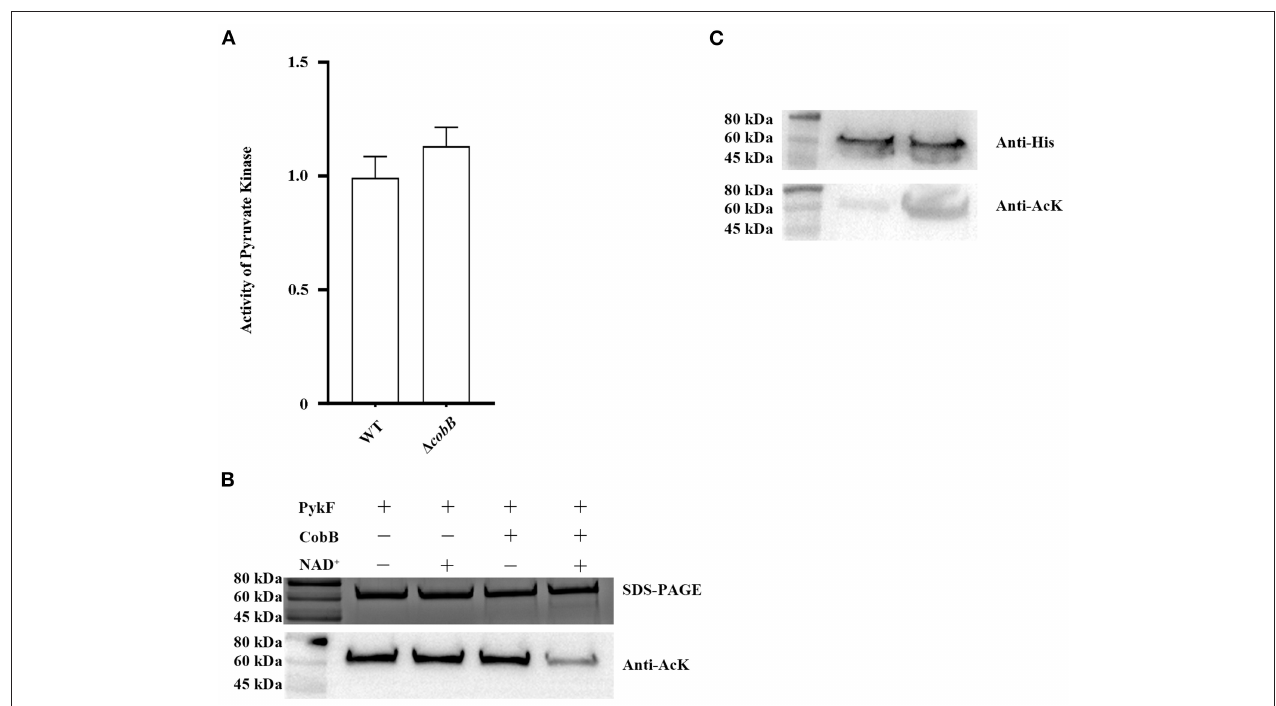
FIGURE 3 | (A) CobB deacetylation PykF in vitro . Top line, Western blot was performed on PykF treated with CobB for 1h. The same amount of protein was loaded in all lanes. Bottom line, pyruvate kinase activity was measured, and the enzyme activity of lane 1 sample was set as 1. Mean values and standard deviations were calculated based on three replicates ( n = 3). Two-tailed P -values were determined by the t -test, and the significance level is 0.05. (B) CobB deacetylates PykF in vivo . Top line, Western blot analysis of purified PykF from V. alginolyticus WT: pykF and 1 cobB : pykF . Lane 1, purified PykF from V. alginolyticus WT: pykF ; Lane 2, purified PykF from V. alginolyticus 1 cobB : pykF . The same amount of protein was loaded in all lanes. Anti-His, His Tag Mouse Monoclonal Antibody. Anti-AcK: anti-acetyl lysine antibody. Bottom line, pyruvate kinase activity of V. alginolyticus WT and 1 cobB . Pyruvate kinase activity of V. alginolyticus WT was set as 1. Mean values and standard deviations were calculated based on three replicates ( n = 3). Two-tailed P -values were determined by the t -test, and the significance level is 0.05.